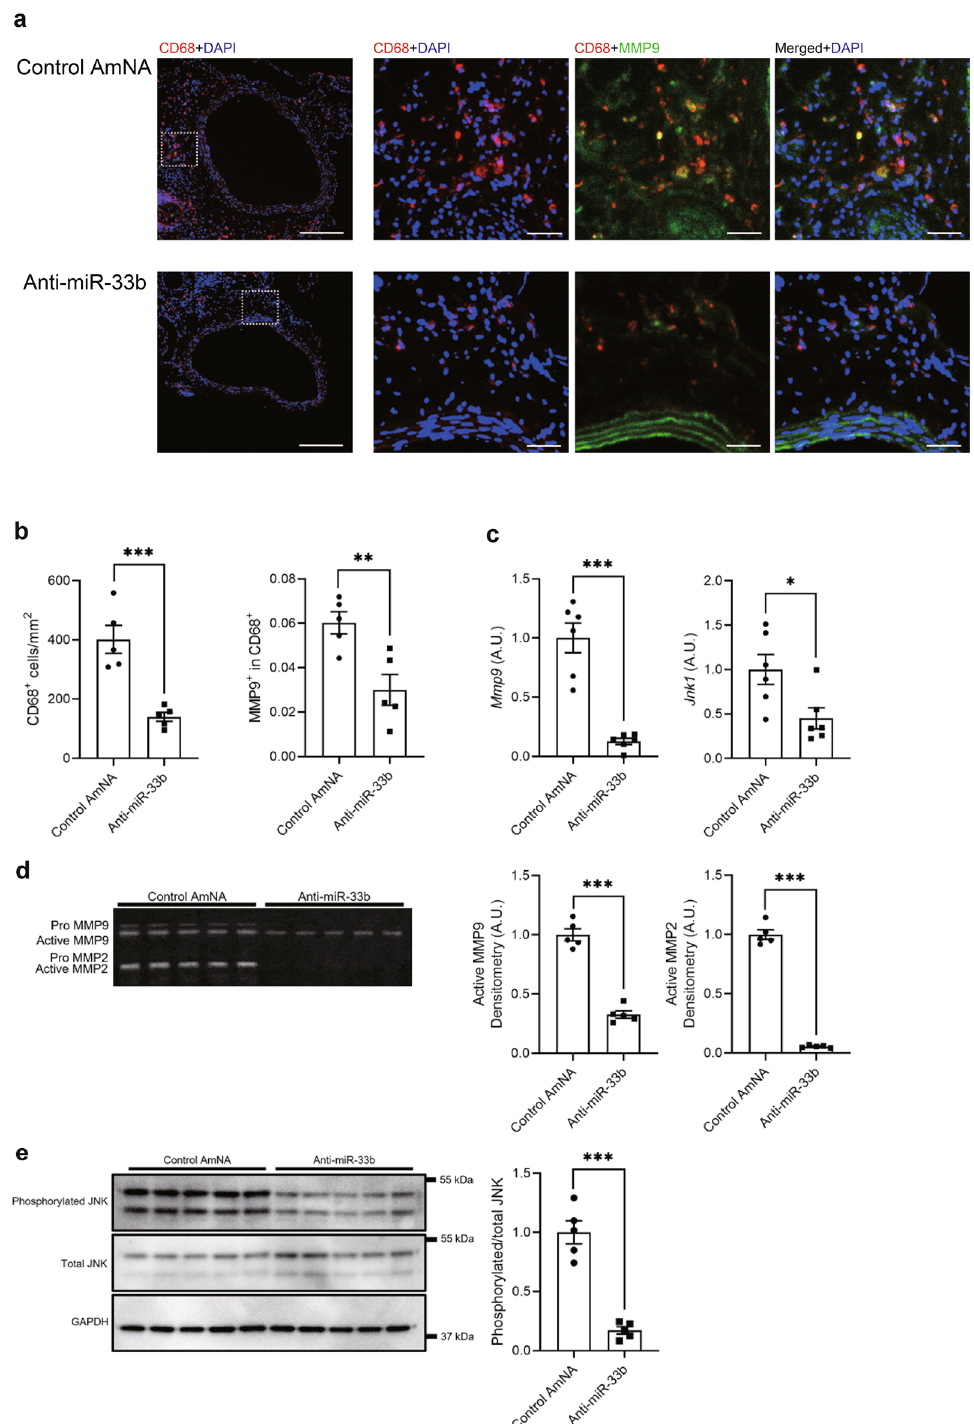
Figure 6. Inhibition of miR-33b in miR-33b KI mice prevents accumulation of macrophages and attenuates the activities of c-Jun N-terminal kinase (JNK) and matrix metalloproteinase 9 (MMP9). ( a ) Representative images of immunofluorescence staining for CD68 (red), MMP9 (green), and 4’,6-diamidino-2-phenylindole (DAPI; blue). Scale bar indicates 200 µm for low power-field and 50 µm for high power-field. ( b ) Numbers of CD68-positive cells and quantification of CD-68/MMP9-double positive area in the sections of CaCl 2 -induced AAA wall, n = 5 in each group. Unpaired two-tailed t test. **P < 0.01 and ***P < 0.001. ( c ) Mmp9 and Jnk1 expression levels in CaCl 2 -induced AAA walls by quantitative real-time PCR, n = 6 mice in each group. Unpaired t test with Welch’s correction (left) and unpaired two-tailed t test (right). *P < 0.05 and ***P < 0.001. ( d ) MMP9 and MMP2 activities of AMO- administered CaCl 2 -induced AAA walls were evaluated using gelatin zymography (left) and quantified using densitometric analyses (right), n = 5 mice in each group. Original gel is presented in Supplementary Fig. S4 online. Unpaired two-tailed t test (active MMP9 densitometry analysis) and unpaired t test with Welch’s correction (MMP2 densitometry analysis). ***P < 0.001. ( e ) JNK activity of AMO-administered CaCl 2 -induced AAA walls was assessed using western blotting (left) and quantified using densitometric analyses (right). GAPDH was served as an internal loading control, n = 5 mice in each group. Original blots are presented in Supplementary Fig. S4 online. Unpaired t test with Welch’s correction. ***P < 0.001. All data represent mean ±